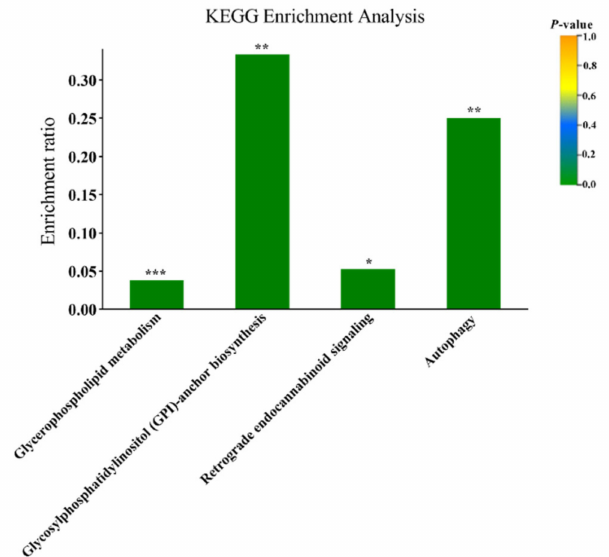
Figure 3. Metabolic pathway enrichment analysis of plasma of cows with di ff erent calving body condition score. The X -axis indicates the name and classification of the pathway. Y -axis represents the enrichment ratio (Enrichment ratio = sample number / background number). “***”, “**”, and “*” in the figure means the value of p < 0.001, < 0.01 and < 0.05, respectively. KEGG, Kyoto Encyclopedia of Genes and Genomes.